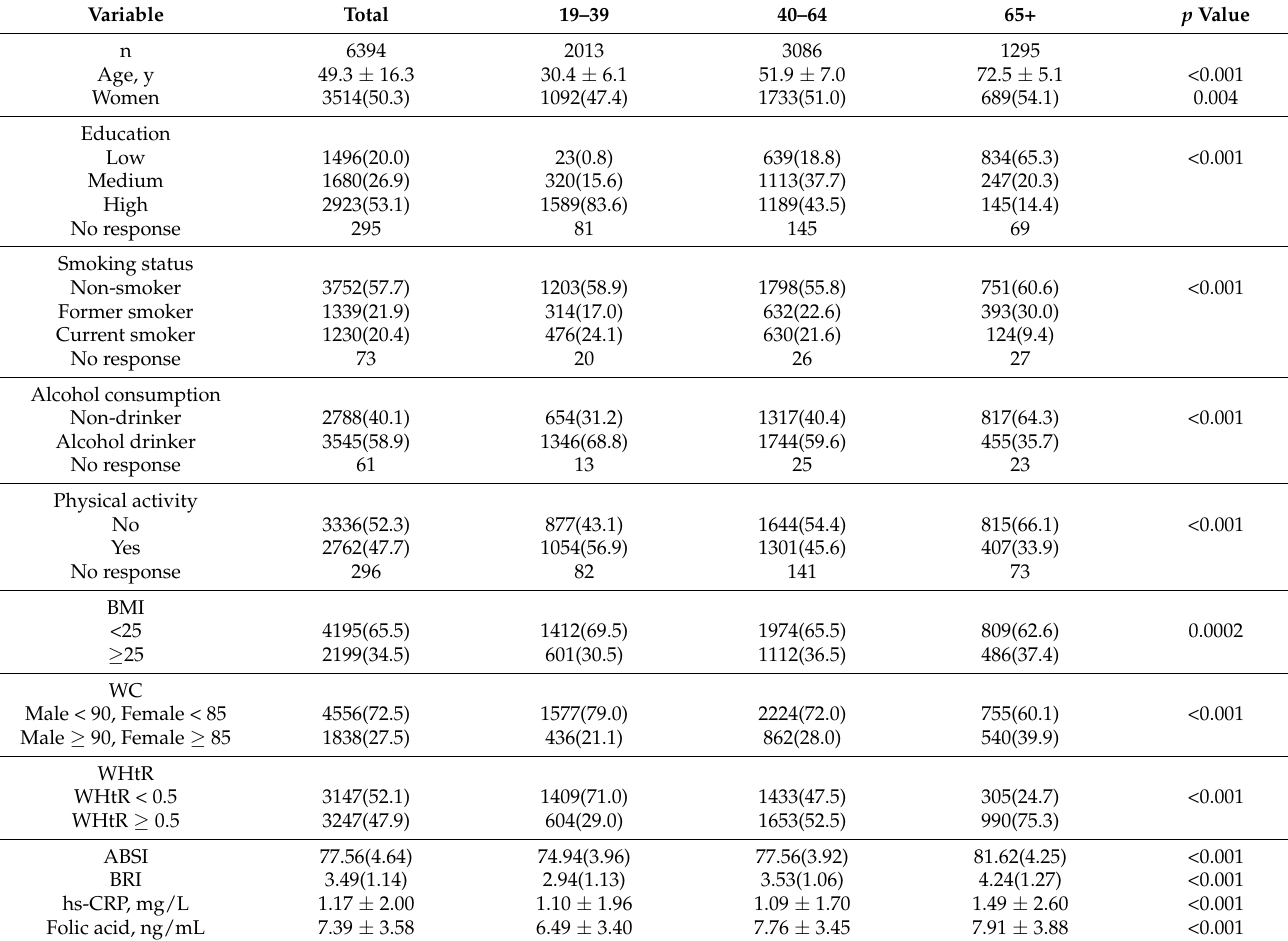
Table 1. Participants’ sociodemographic and clinical characteristics according to age